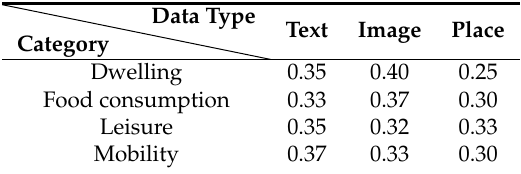
Table 5. The weighted factors obtained by asking the user